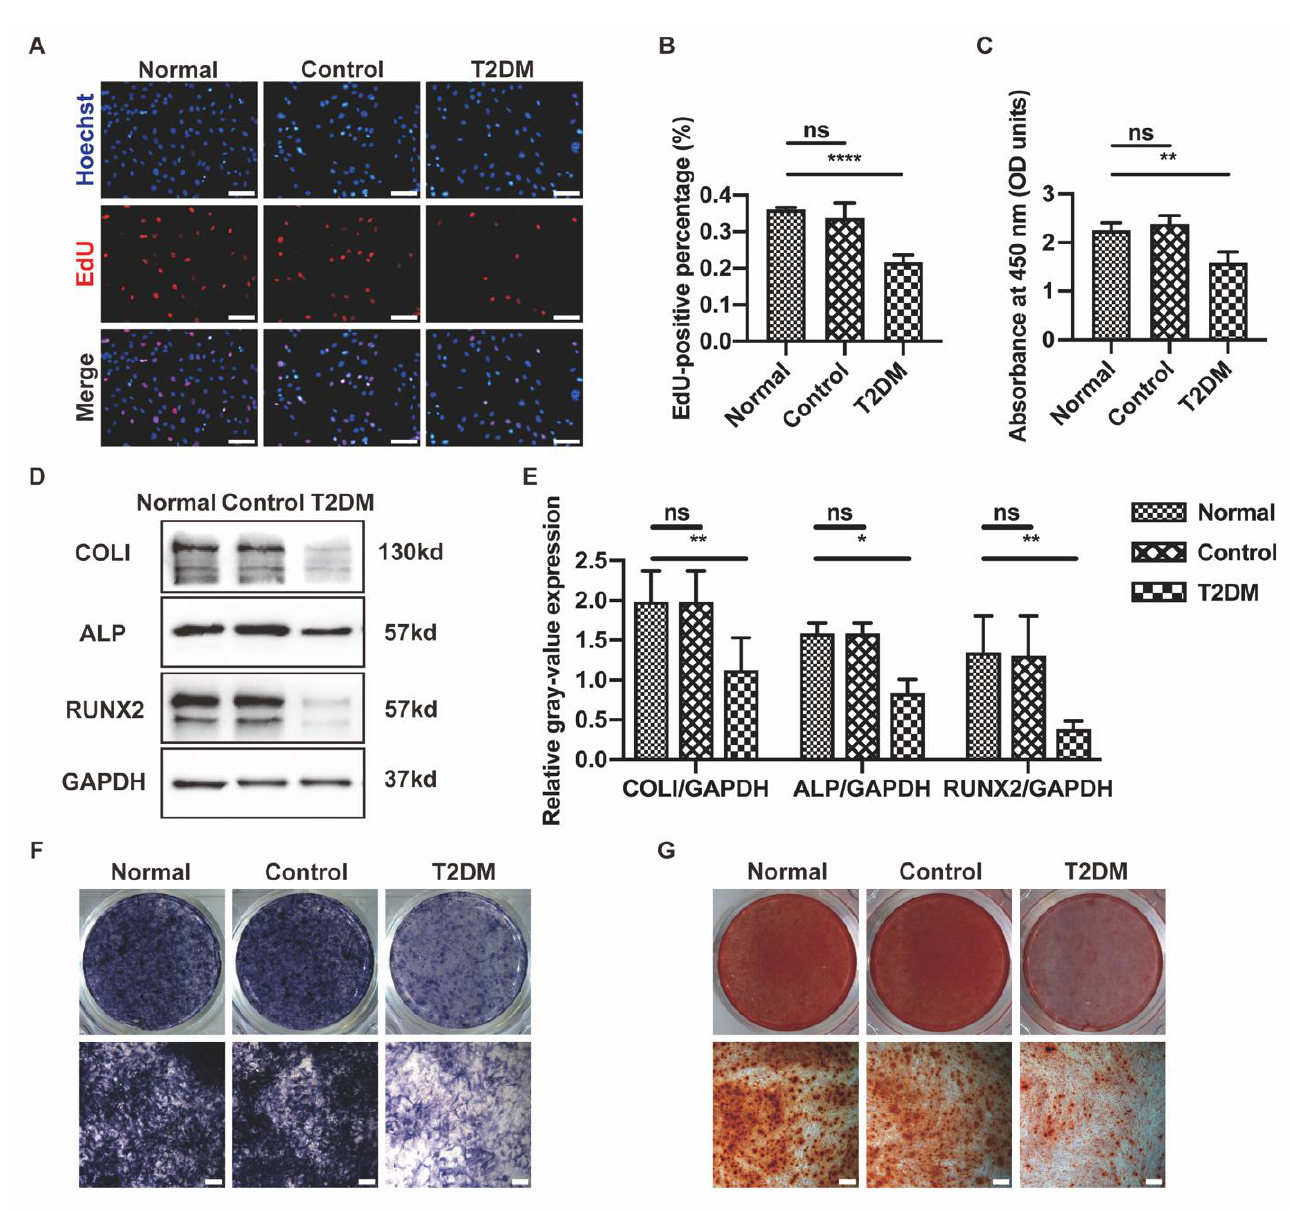
Figure A1. High-glucose conditions inhibited the osteogenic ability of osteoblasts, whereas a high- osmolarity environment did not. ( A ) EdU staining was used to evaluate the osteoblasts performing DNA replication. EdU-positive nuclei (red) and all nuclei (blue). Scale bar = 100 µ m. ( B ) Quantitive analysis of cells with EdU staining. ( C ) The Cell Counting Kit-8 assay was performed on the second day of incubation. ( D ) Western blot analysis was utilized to assess the protein levels of COLI, ALP, and RUNX2 after seven days of osteogenic induction. ( E ) The investigation of gray-value expression quantification in the Western blot analysis. ( F ) ALP staining after a week of osteogenic stimulation. Scale bar = 200 µ m. ( G ) ARS staining after a 14-day osteogenic induction. Scale bar = 200 µ m. Data are presented as the means ± SDs from three separate experiments (n = 3). ns p > 0.05; * p < 0.05; ** p < 0.01; **** p < 0.0001. Normal group: α -MEM with 5.5 mM glucose; Control group: 20 mM mannitol and palmitate vehicle added to the Normal medium of 5.5 mM glucose; T2DM group: 25 mM glucose and 200 mM sodium palmitate added to the mimic diabetic condition.